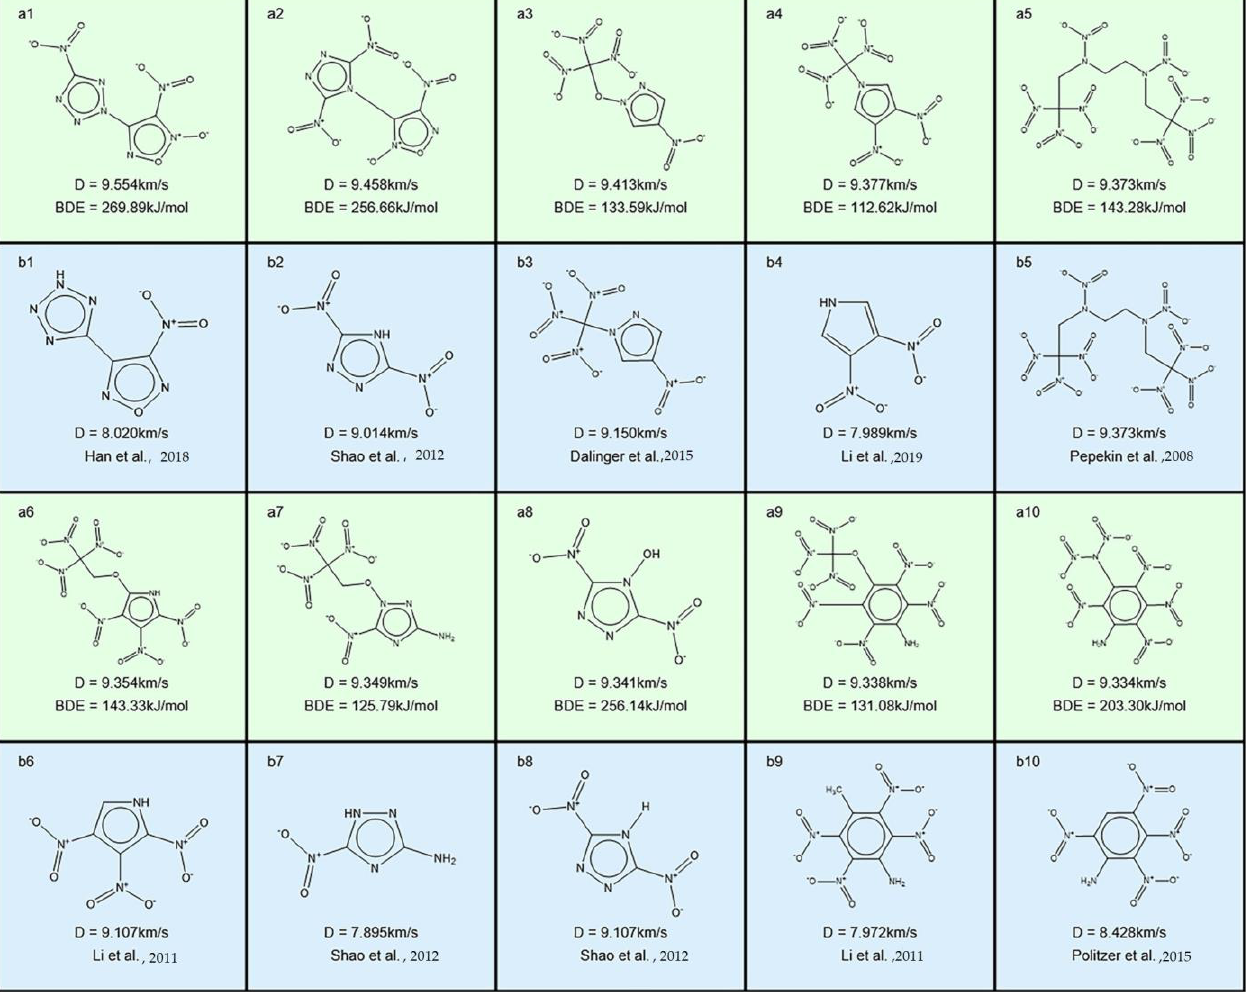
Figure 14. Structures of the top 10 molecules and similar compounds reported. The pale green and light blue backgrounds denote the molecules generated by Li et al. [79] and the similar molecules reported [112 – 118], respectively. D and BDE represent the detonation velocity and bond dissociation energy, respectively [79] . Copyright 2022 American Chemical Society.